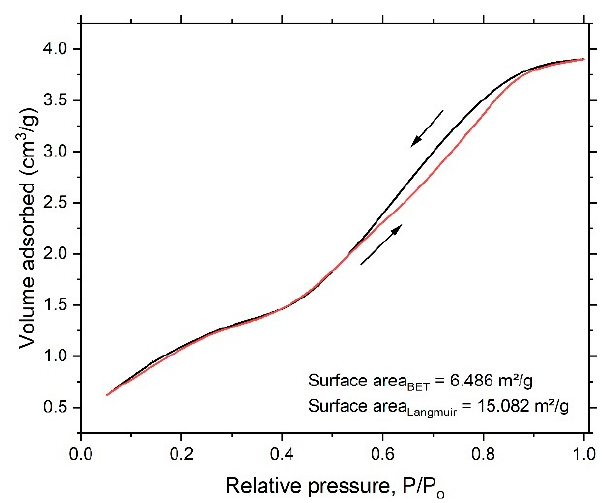
Figure 4. N 2 adsorption/desorption isotherm for the dealloyed sample.